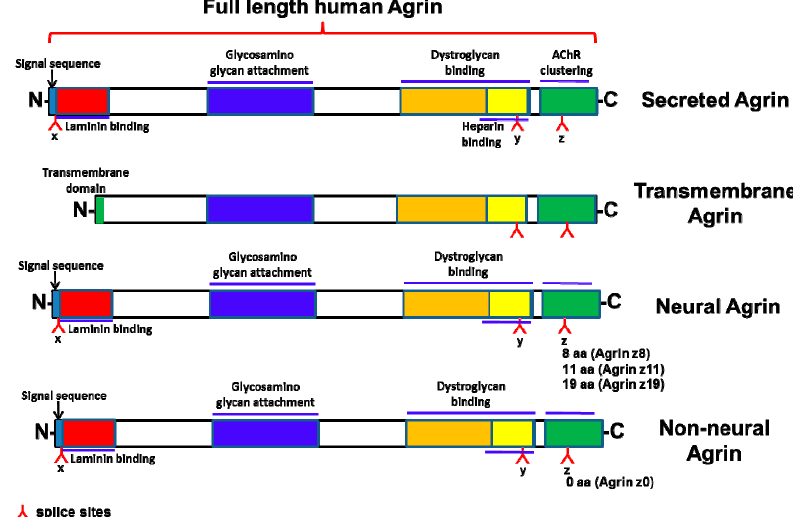
Figure 1. Cartoon showing the different forms of Agrin.